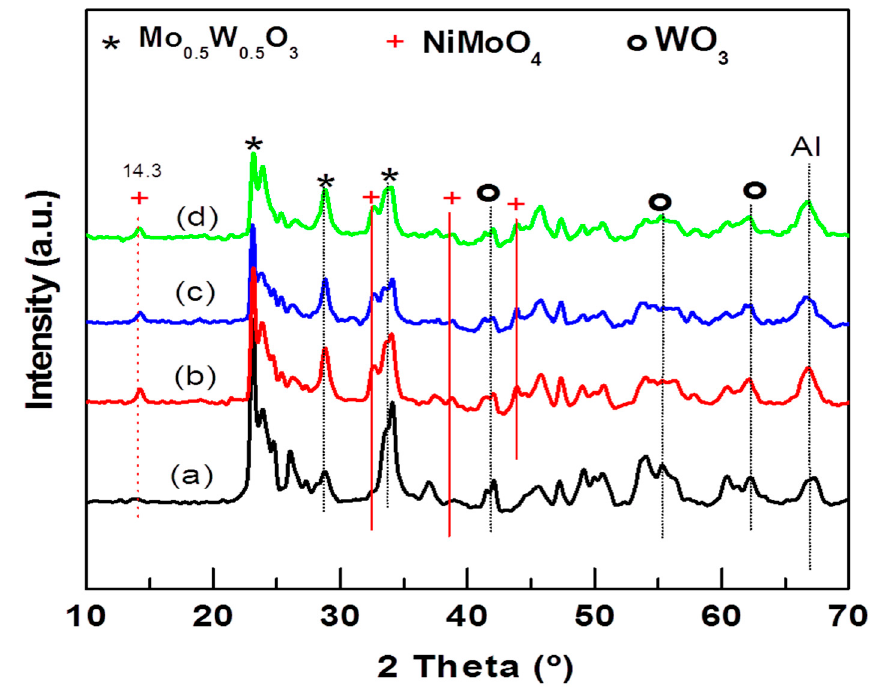
Figure 5. X-ray diffraction patterns of calcined NiMoW/Al and NiMoW/Al-Ce( x ) catalysts: ( a ) Ni- MoW/Al; ( b ) NiMoW/Al-Ce5; ( c ) NiMoW/Al-Ce10, and ( d ), NiMoW/Al-Ce15. XRD patterns of all NiMoW/Al-Ce( x ) calcined catalysts also exhibit peaks at 2 θ = 14.29 ◦ , 32.58 ◦ , 38.7 ◦ , and 43.87 ◦ corresponding to the (110), (022), ( − 132), and (330) planes of crys- talline nickel molybdenum oxide (NiMoO 4 ; JCDPS 000-033-0948). The diffraction peaks at 23.6 ◦ , 33.64 ◦ , 41.46 ◦ , 54.57 ◦ , and 60.25 ◦ in 2 θ correspond to the (200), (220), (222), (420), and (422) planes, respectively, of the crystalline WoO 3 phase (JCDPS 00-046-1096). In addition, all calcined catalysts show the peaks characteristic of the Mo 0.5 W 0.5 O 0.3 phase (JCPDS 00-028-0667). For the Al-Ce( x ) supported catalysts, the intensity of the NiMoO 4 peaks increased while those of the WO 3 and Mo 0.5 W 0.5 O 0.3 phases decreased with respect to the same peaks observed in the Ce-free sample pattern. The decrease in the peaks corresponds to the WO 3 and Mo 0.5 W 0.5 O 0.3 phases, with increasing CeO 2 content, suggesting that the modification of the alumina with CeO 2 improves the dispersion of these